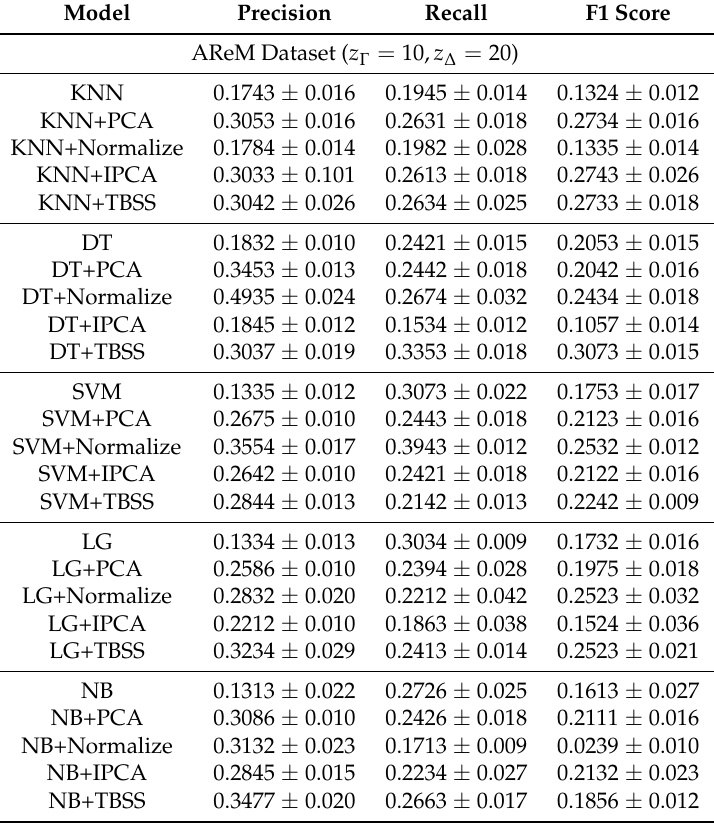
Table 3. The performance of TBSS and other pre-processing methods on AReM recognition